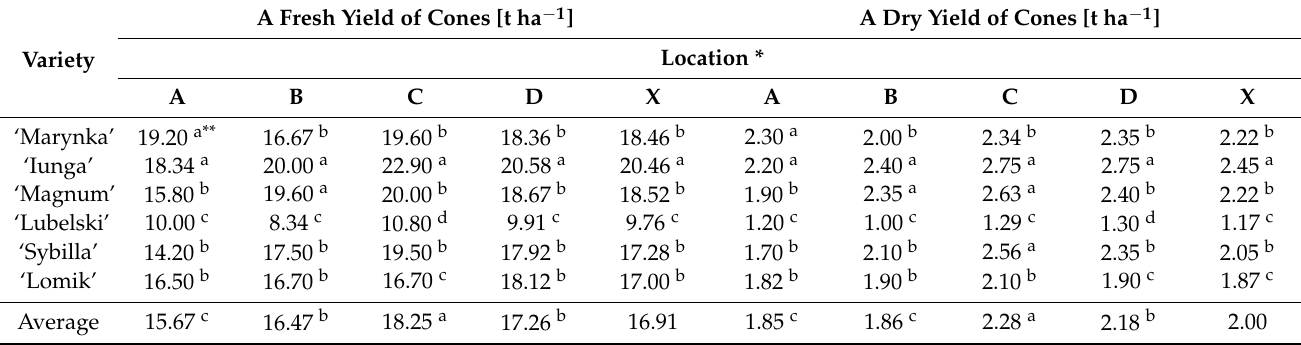
Table 8. Fresh and dry yield of hop ( H. lupulus L.) [t ha − 1